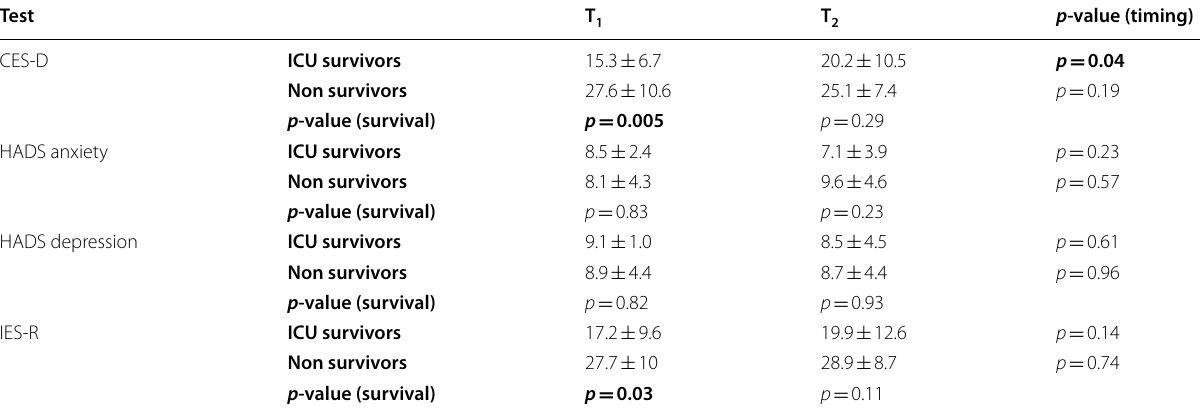
Table 4 Subgroup analyses according to the results of questionnaires for depression, anxiety, and post-traumatic stress disorder between video-calls (“timing”) according to the patient’s survival in the intensive care unit (ICU)